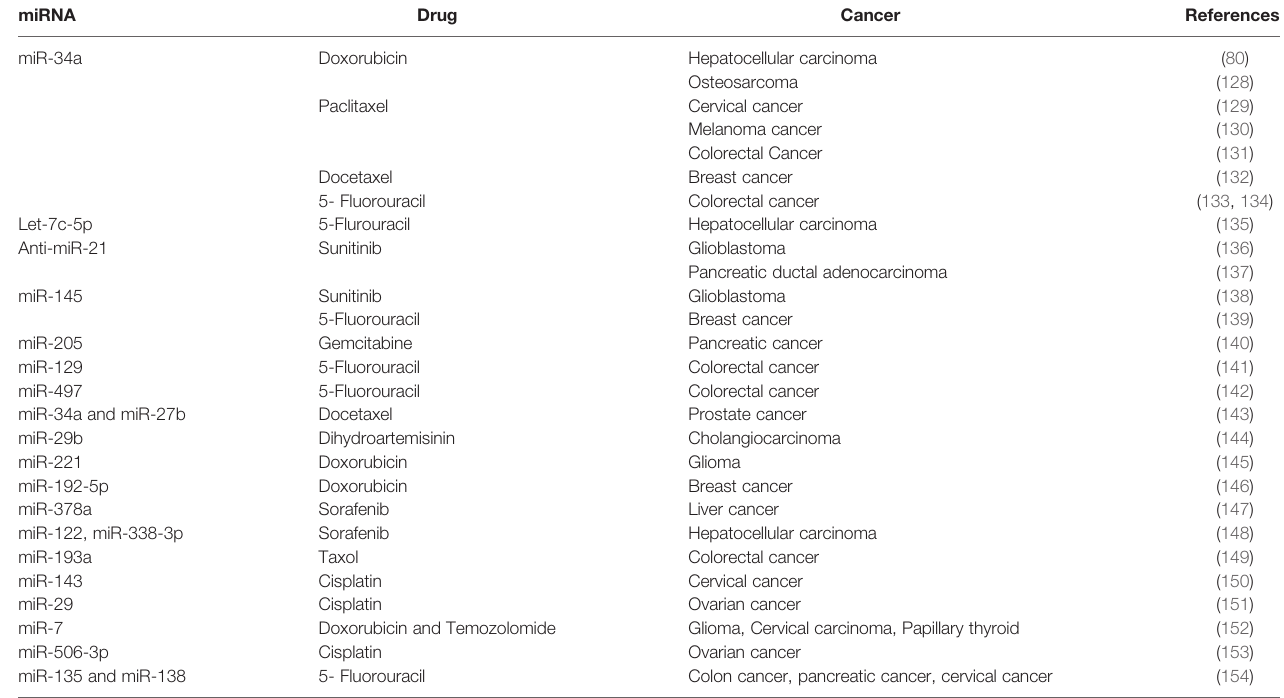
TABLE 1 | Representative examples of combinatorial miRNA-chemotherapeutics treatments. miRNA